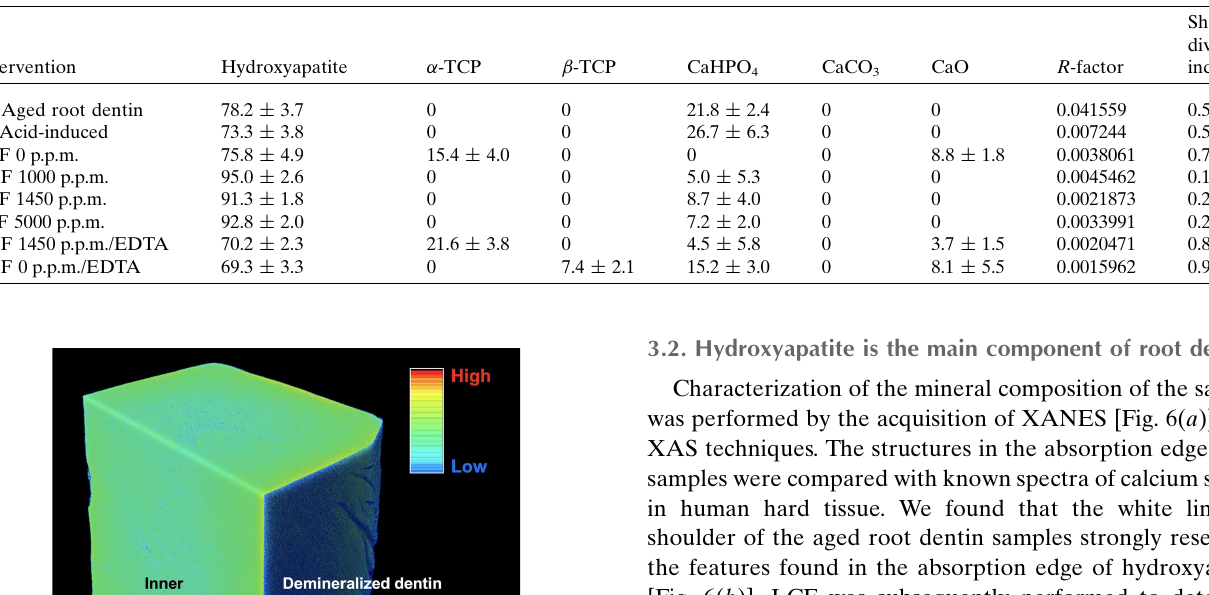
Table 1 The percentage and standard deviation of investigated calcium species in each treatment group and calculated Shannon diversity index.